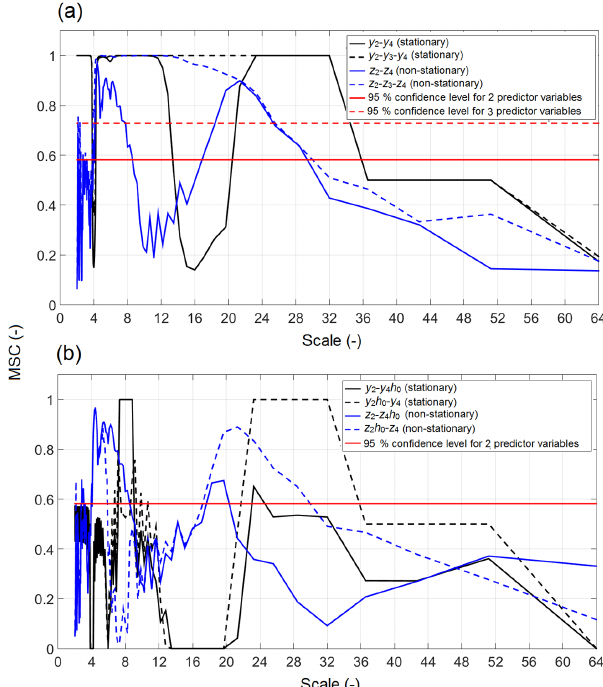
Figure 5. Multiple spectral coherence (MSC) of an artificial data series ( y or z) encompassing five cosine waves ( y 1 to y 5 ; or z 1 to z 5 ) with different scales and (a) two ( y 2 and y 4 ; or z 2 and z 4 ) or three ( y 2 , y 3 , and y 4 ; or z 2 , z 3 , and z 4 ) data series, and (b) two ( y 2 and y 4 ; or z 2 and z 4 ) data series when the second half of one data series is replaced by 0. The variables y 2 h 0 (or z 2 h 0 ) and y 4 h 0 (or z 4 h 0 ) refer to the new series of y 2 (or z 2 ) and y 4 (or z 4 ) in which the second half is replaced by